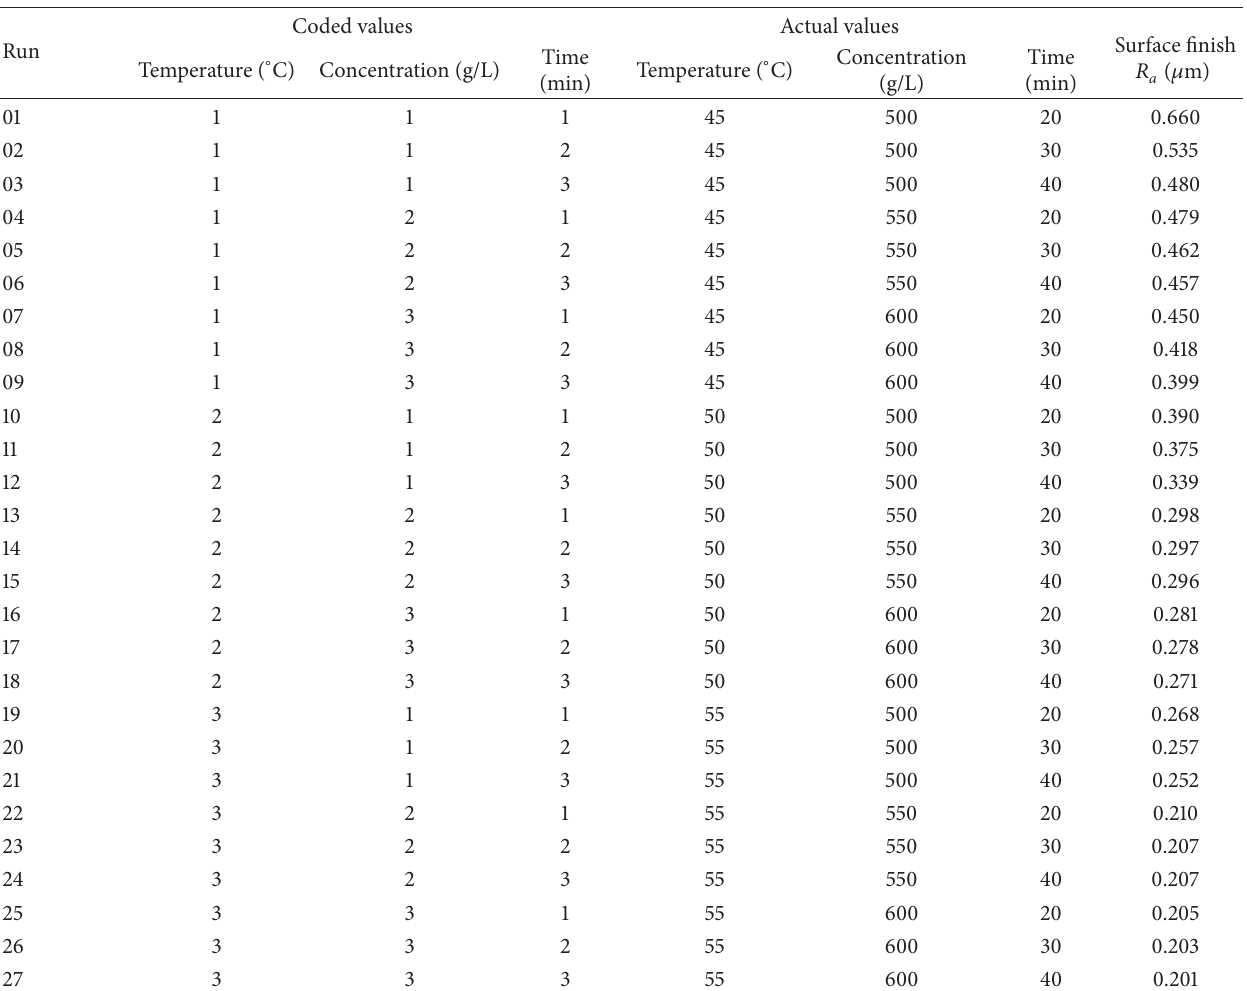
Table 2: Experimental layout with coded and actual